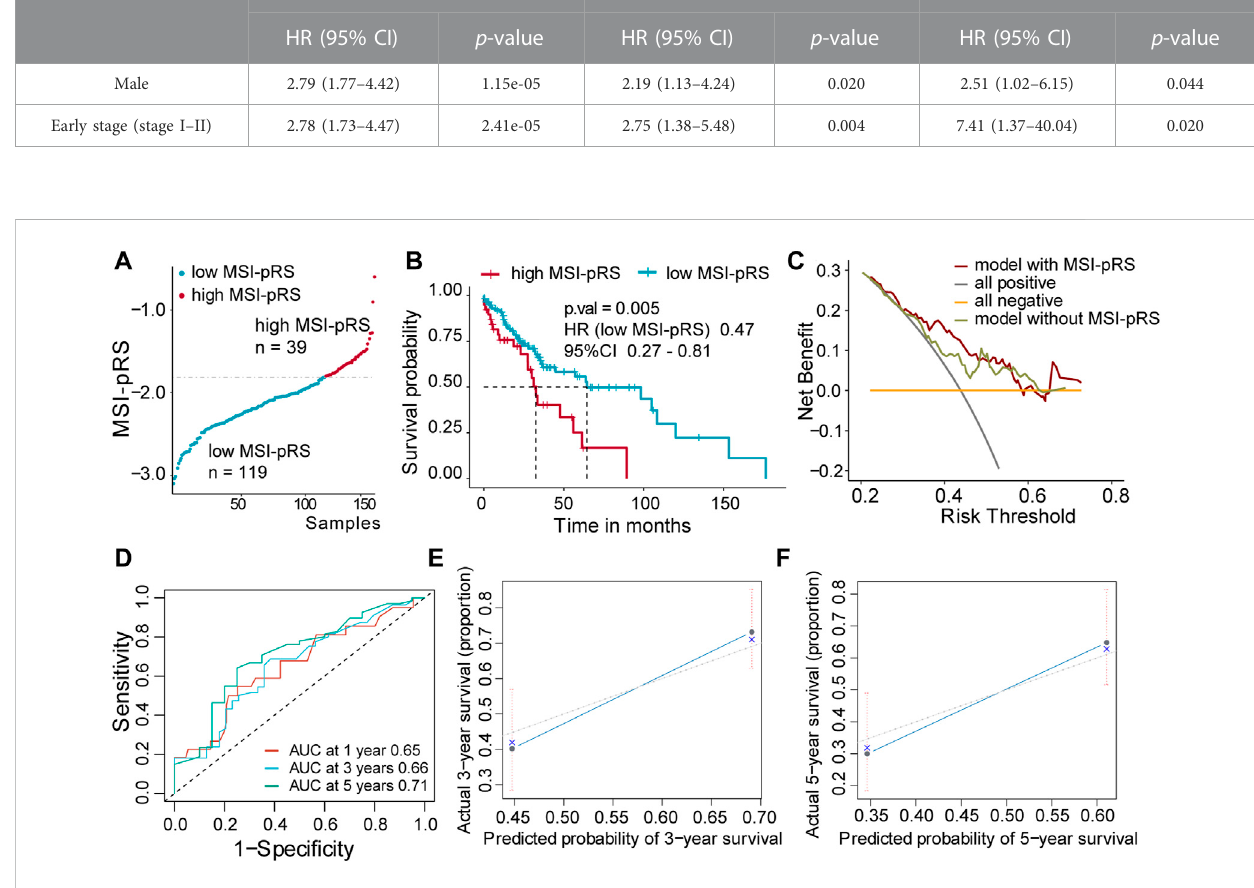
Figure 9A; Supplementary Figure S3A). The MSI-pRS of normal samples was calculated for control. Compared with normal patients,